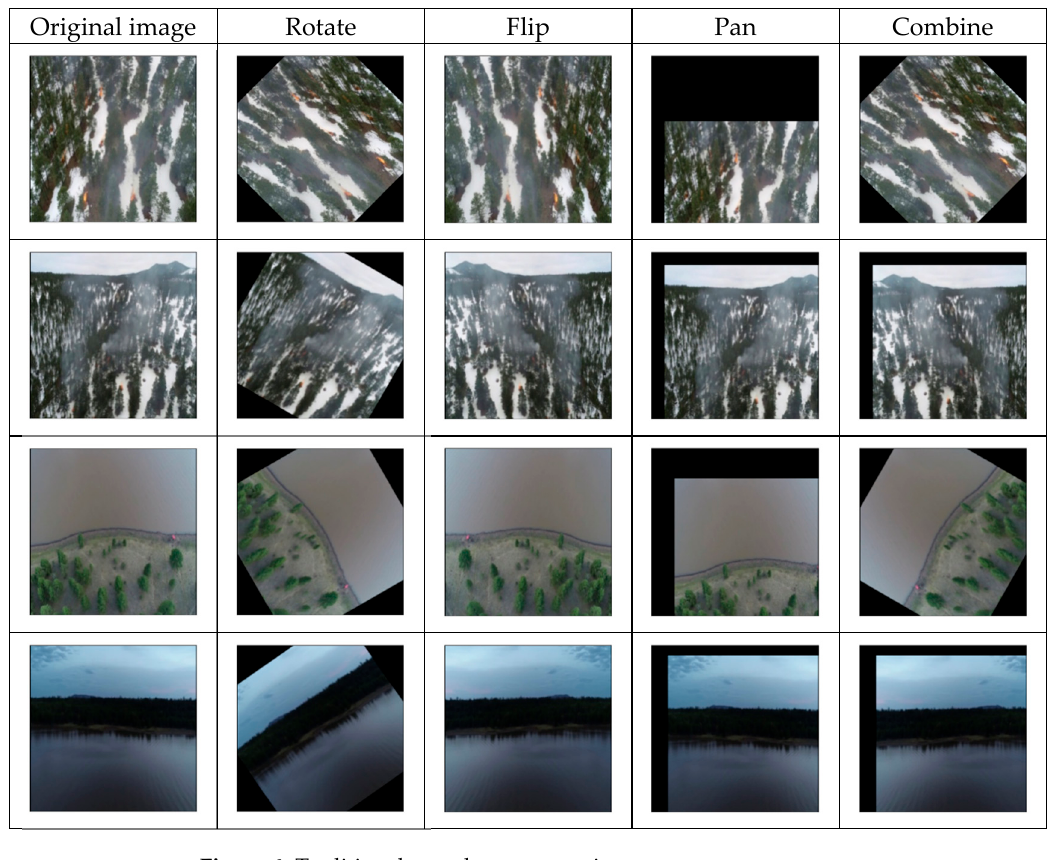
Figure 6. Traditional sample augmentation.